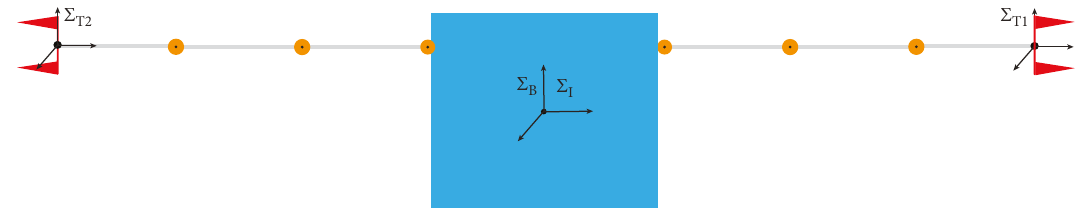
Figure 2: The model of a three-link dual-arm planar robot at the initial con fi guration.